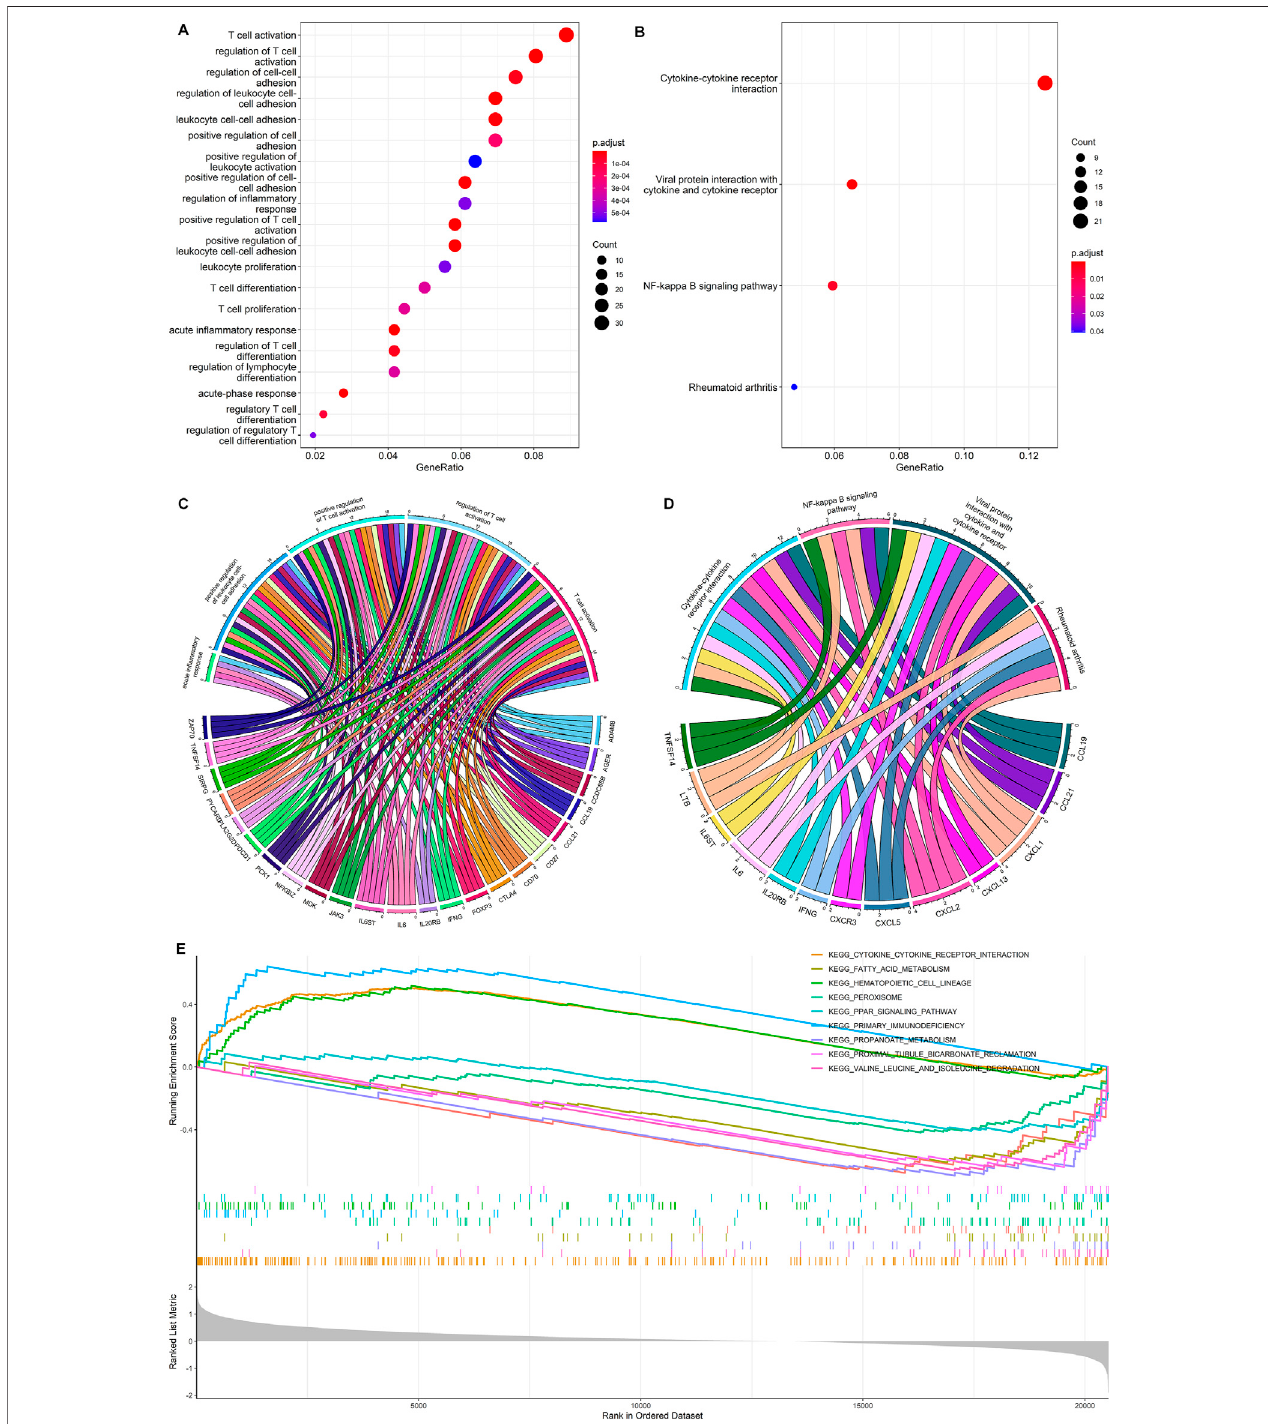
FIGURE5| Functionalenrichmentanalysis. (A,C) GOenrichmentanalysisfortheDEGsbetweenthehigh-andlow-riskgroup. (B,D) KEGGenrichmentanalysisfor the DEGs between the high- and low-risk group. (E) Gene set enrichment analysis for DEGs between the high- and low-risk groups.